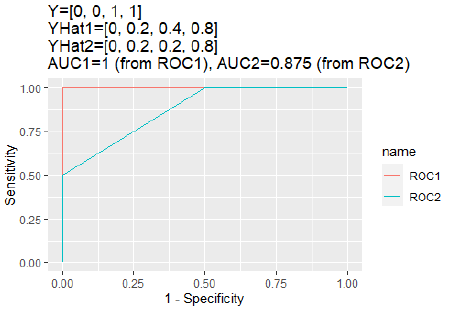
Figure 7. Two paths of ROC curves: ROC1 and ROC2. For each ROC curve, we can compute the AUC value. From ROC1, we can compute AUC1. From ROC2, we can compute AUC2. The mistake discussed in this section is reflected by a reduction in AUC values from path 1 to path